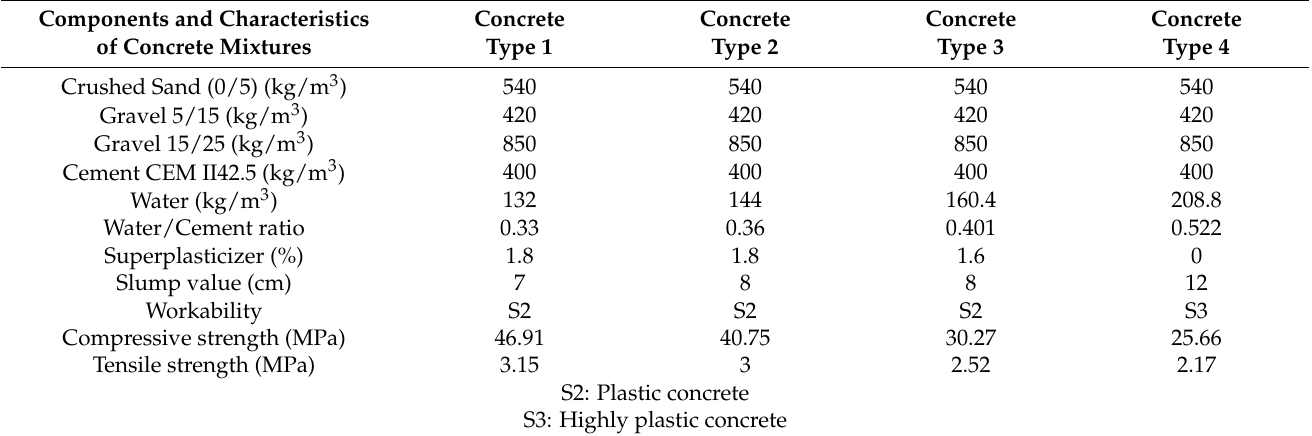
Table 3. Mixtures’ design and main properties of concrete types.